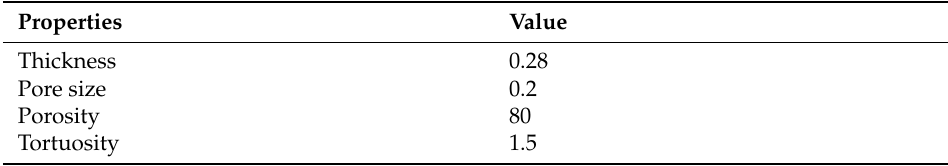
Figure 2. Evolution of permeate flux as a function of feed temperature [48]. Table 3. Characteristic of the used membrane [48] .